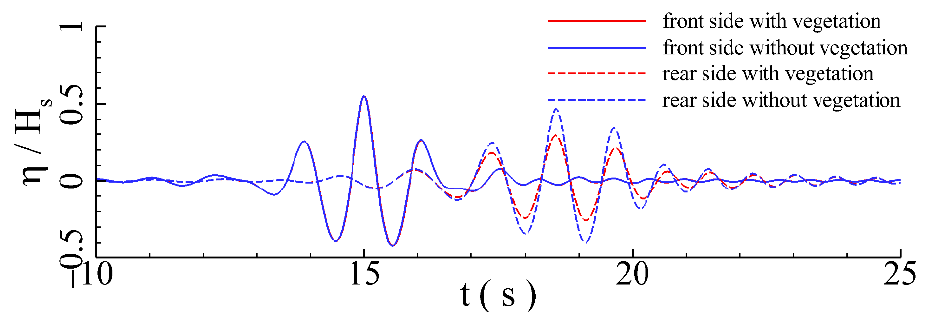
Figure 8. Water elevations at front and rear sides of the emergent vegetation patch.